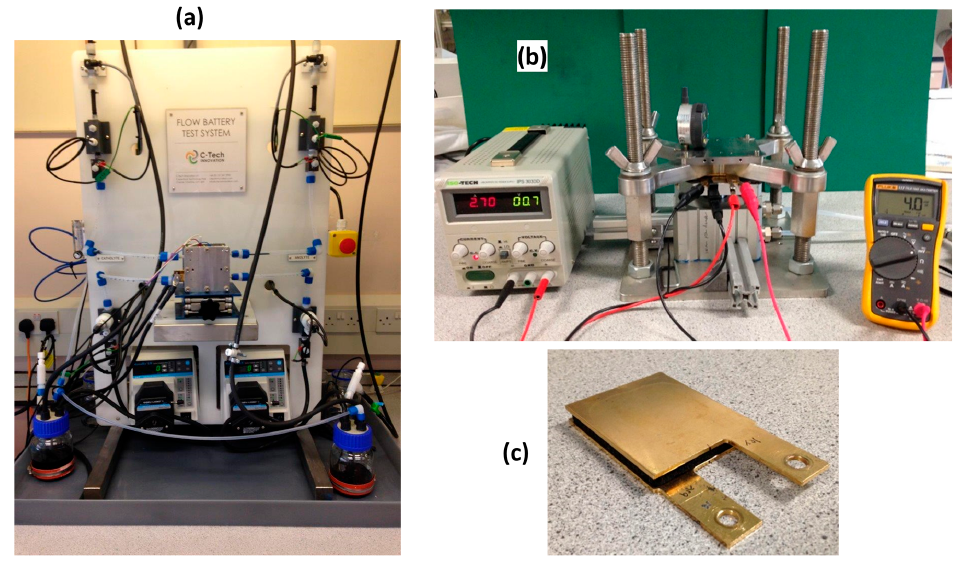
Figure A2. Photographs of ( a ) the VRFB test rig, ( b ) the bespoke rig used to measure electrode resistance and thickness under different compressions and ( c ) the electrode-metal plate assembly placed in the compression rig in ( b ).